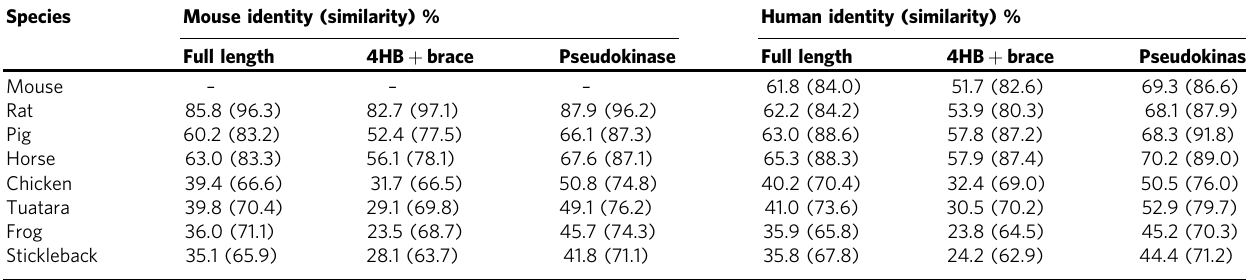
Table 1 Pairwise amino acid sequence identity and similarity of MLKL orthologues over full-length sequence and component